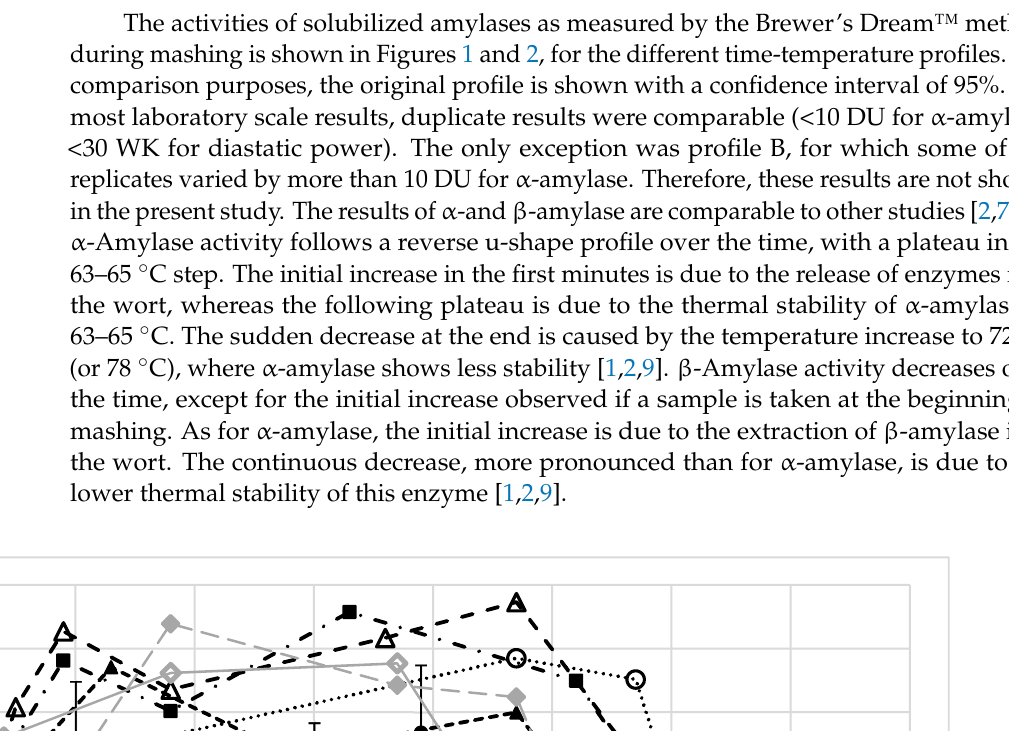
( b ) Figure 1. ( a ) α -Amylase and ( b ) β -Amylase activity of the different mashing profiles studied at lab scale measured with Brewer’s Dream™ kits. The heating rate in all profiles was 1 °C/min. Mash out temperature was 78 °C, which was held for 1 min.